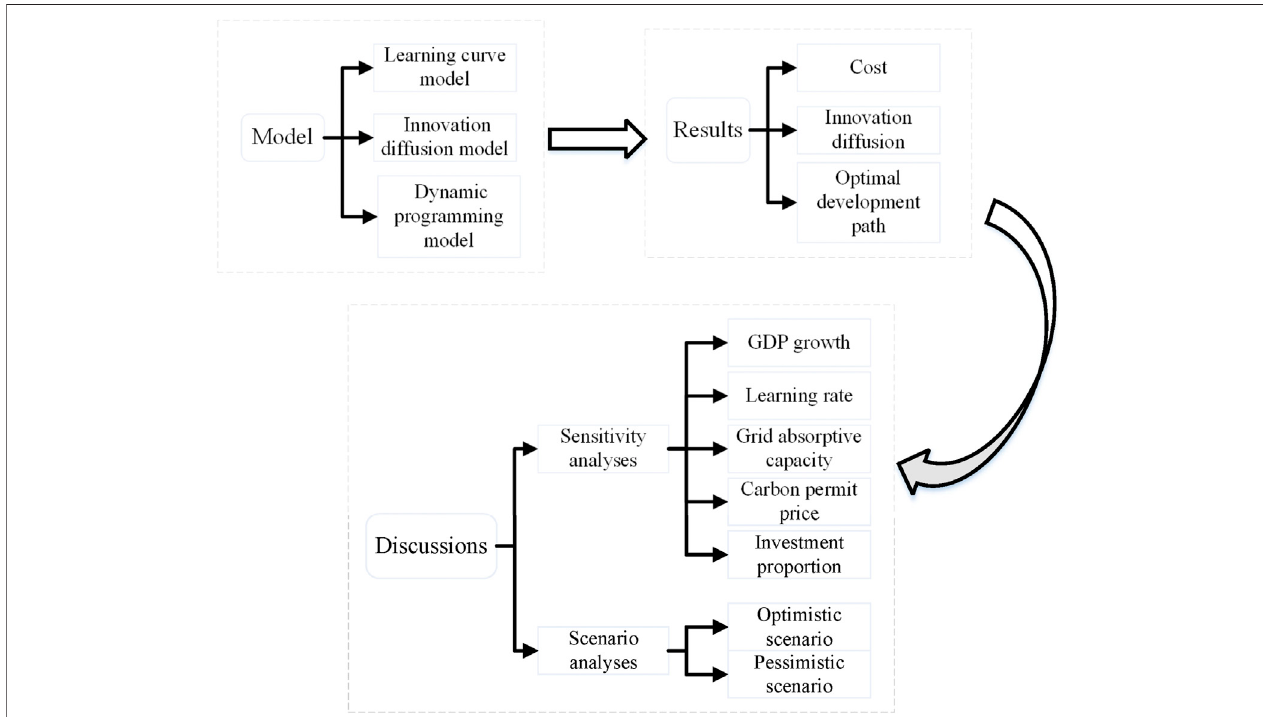
FIGURE 2 | Flowchart of models, results, and